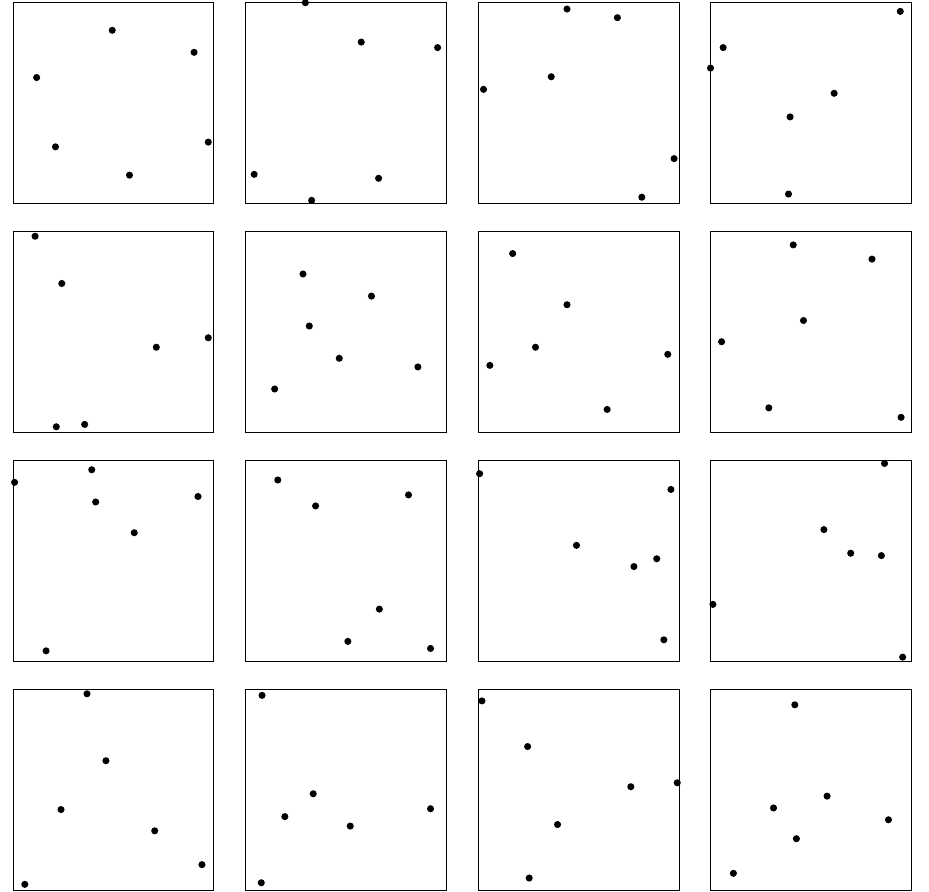
Figure 3. The 16 subsets of C 6 in the database of [14] and